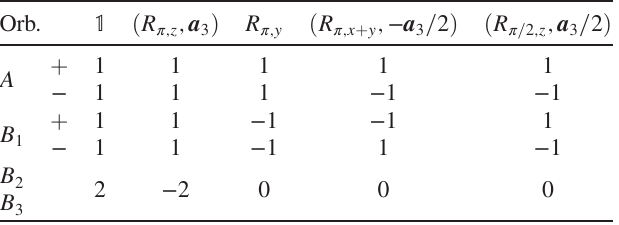
rotation, we can also obtain the horizontal hopping matrices